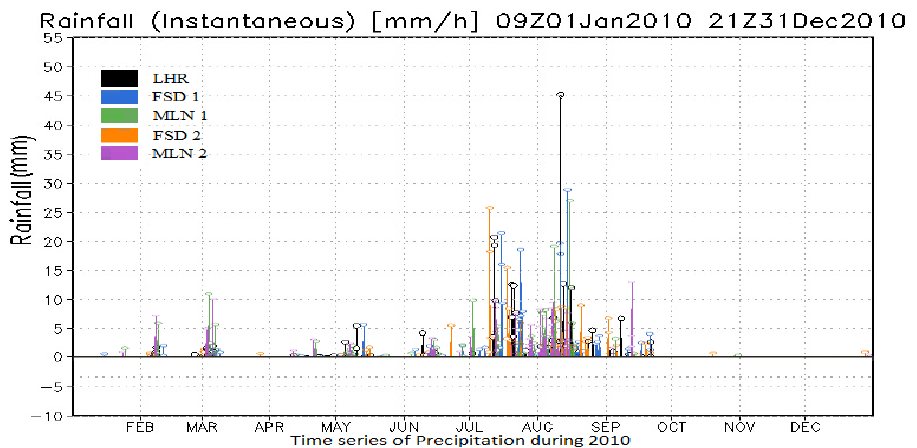
Figure 10. Real-time TRMM and TMPA rainfall data with temporal resolution. Real-time rainfall (instantaneous mm/h) data at 1 km resolution during (09Z01Jan2010 to 21Z31Dec2010) for five stations show heavy rainfall from JD-185 to JD-232.